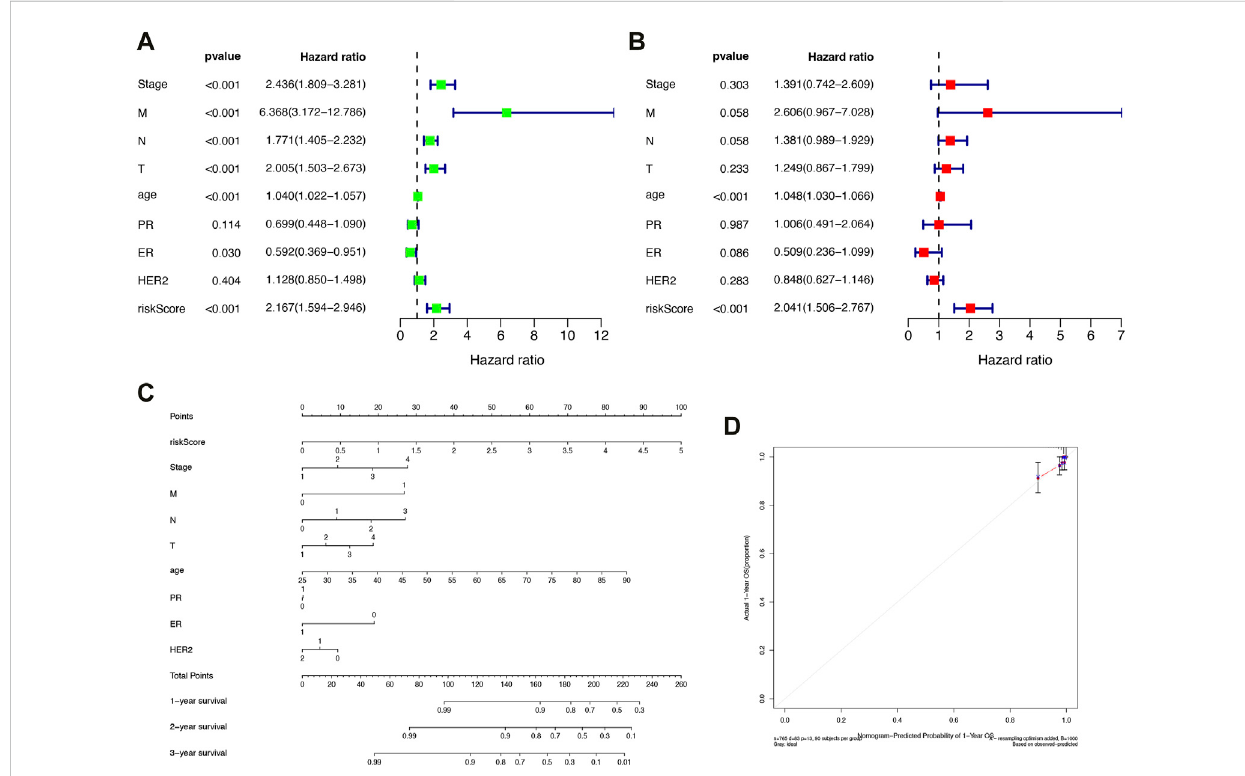
FIGURE 5 Construction of independent prognostic factors and nomogram. (A) Univariate Cox regression analysis. (B) Multivariate Cox regression analysis. (C) Survival nomogram based on the total TCGA cohort. (D) Calibration curves for predicting 1, 3, and 5-year survival of BRCA patients in the TCGA